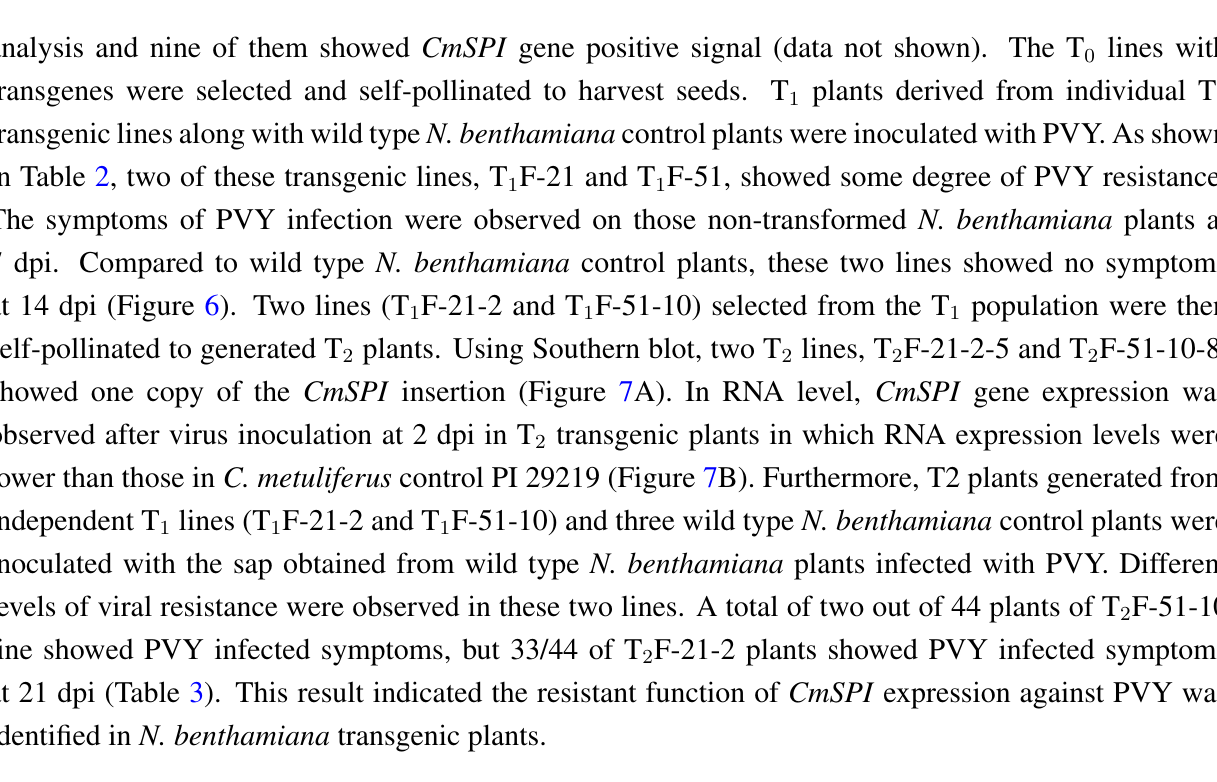
Table 2. Infectivity assays of T